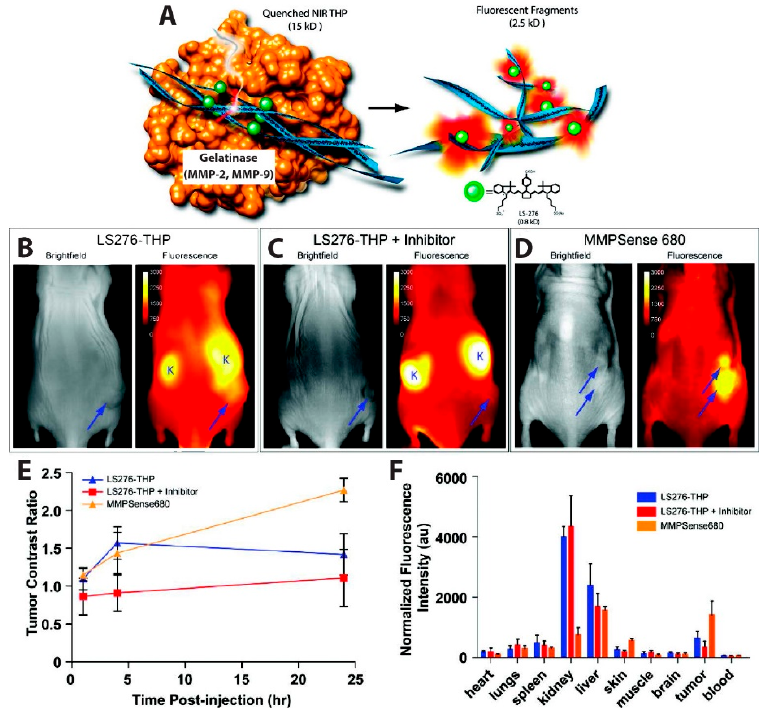
Figure 5. MMP overexpression in tumors detected with activatable NIR probe. ( A ) Schematic of the activatable probe. A type-V collagen sequence containing repeating Gly-Pro-4-hydroxy- L -proline (GPO) triplets conjugated to the NIR dye LS276 forms a triple helical peptide (THP) structure, quenching the dye emission through homoFRET. In the presence of MMP-2 or MMP-9, the THP is fragmented through enzymatic cleavage, resulting in enhanced brightness from the NIR probe. Images taken 24 h after i.p. injection of ( B ) LS276-THP; ( C ) LS276-THP with the MMP inhibitor Ilomastat; or ( D ) commercially available MMPSense 680. ( B – D ) The tumors are represented by an arrow and the kidney marked with the letter “K”. ( E ) Time-dependent evolution of NIR fluorescence shown by plotting the tumor contrast ratio, i.e., the ratio of the fluorescence intensity in the tumor and in a region of interest on the contralateral flank. ( F ) Plot of ex vivo fluorescence intensities by organ showing lower fluorescence intensity in the tumor when the inhibitor is present; other organs like the liver and kidney were not similarly impacted by the inhibitor. Fluorescence images were recorded at 830 ± 75 nm using excitation of 755 ± 35 nm for LS276 and 680 nm excitation and 720 nm emission for the MMPSense. Reprinted with permission from [110]. Copyright 2012 American Chemical Society.